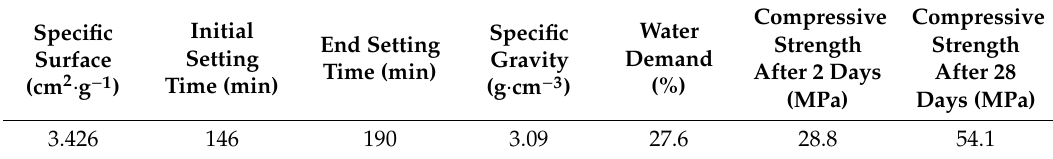
Table 2. Physical properties of Portland cement CEM I 42.5R [44].